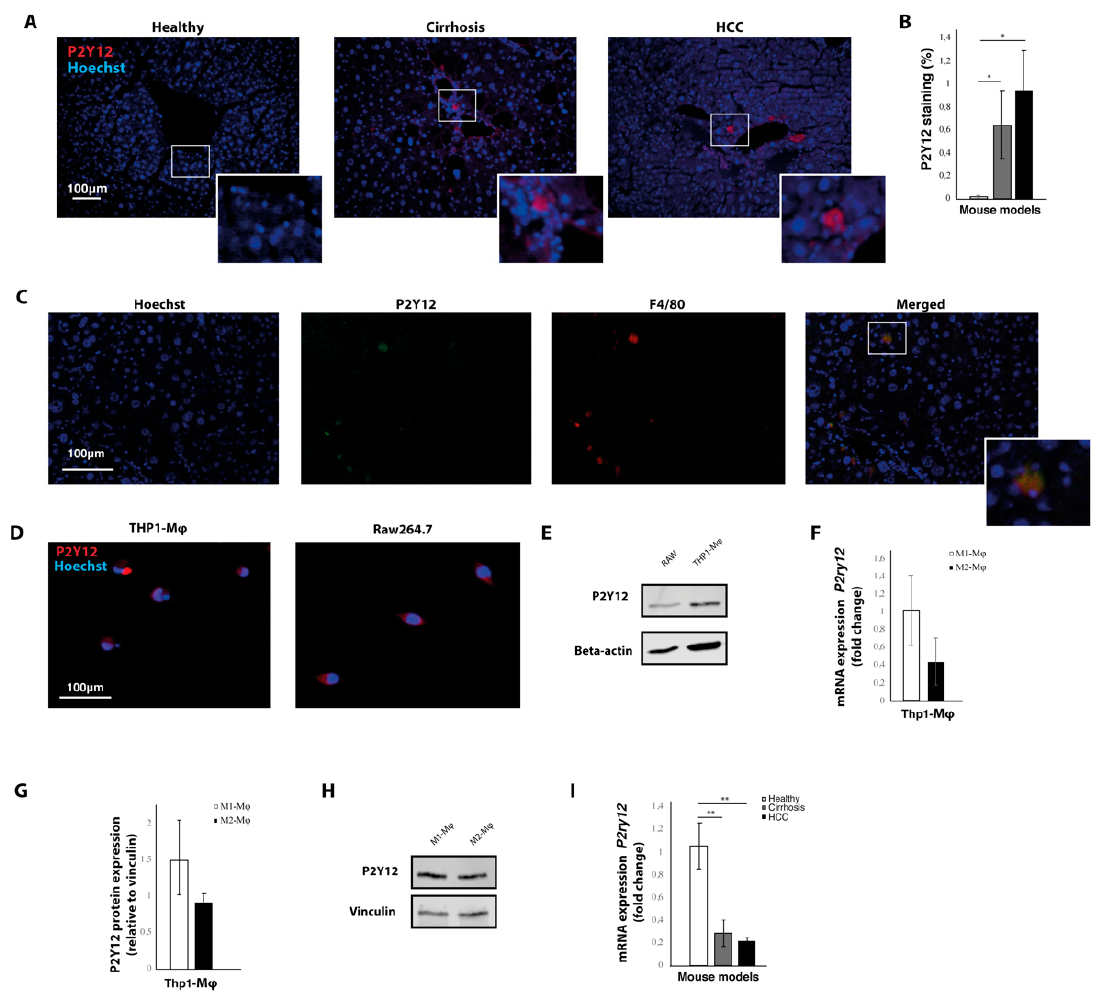
Figure 1. The P2Y12 receptor is expressed in mouse models for liver cirrhosis and hepatocellular carcinoma. ( A ) Immunohistochemical staining with P2Y12 antibodies of liver sections from healthy mice, mice with carbon tetrachloride (CCL 4) -induced liver cirrhosis and mice with diethylnitrosamine (DEN)-induced liver cancer. ( B ) Quantification of immunohistochemical staining with P2Y12 antibodies. ( C ) Co-staining of P2Y12 and macrophage marker F4/80 in liver slides from DEN-induced hepatocellular carcinoma (HCC). ( D ) Immunocytochemical staining of THP1-differentiated macrophages and Raw264.7 cells. ( E ) Western Blot image of P2Y12 protein expression and beta-actin protein in THP1-differentiated macrophages and Raw264.7 cells. ( F ) mRNA expression levels of P2yr12 in interferon gamma and lipopolysaccharide-stimulated anti-tumoral (M1) macrophages and interleukin (IL)-13 and IL-4-stimulated pro-tumoral (M2) macrophages ( G ) Quantification of protein expression in pro-tumoral (M2) and anti-tumoral (M1) macrophages. ( H ) Representative image of Western blot showing P2Y12 protein expression in pro-tumoral (M2) and anti-tumoral (M1) macrophages. ( I ) mRNA expression of P2yr12 in livers from healthy mice, mice with CCL4-induced liver cirrhosis and mice with DEN-induced liver cancer. * = p < 0.05; ** = p < 0.01.